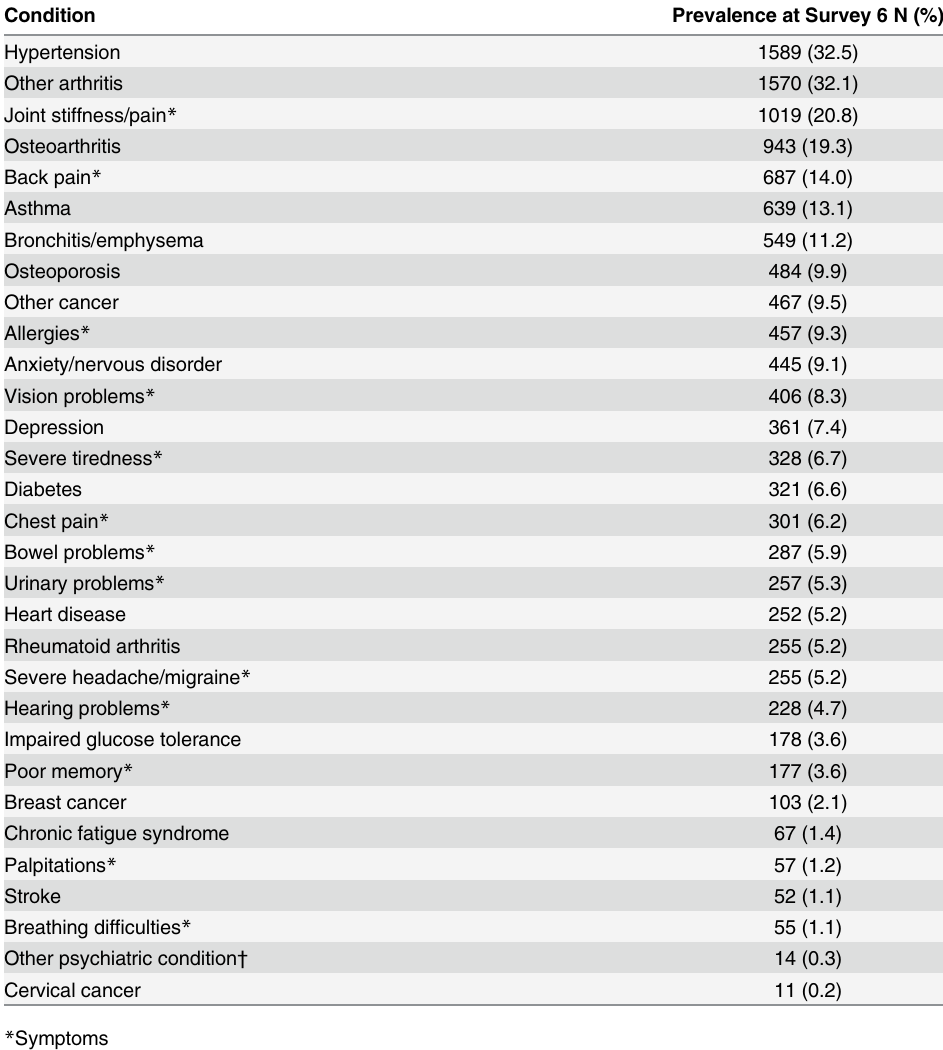
Table 1. Prevalence of conditions at survey